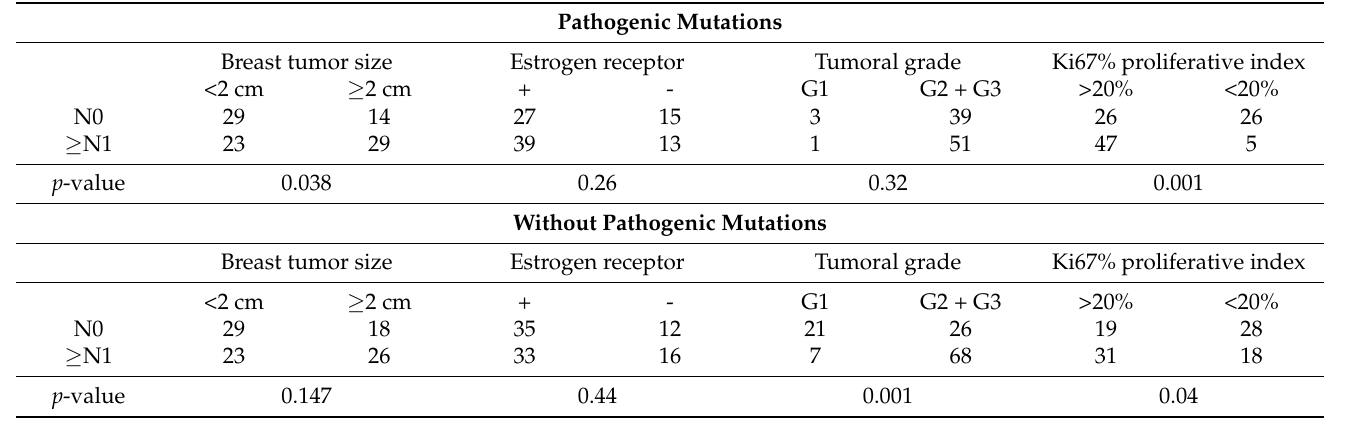
Table 3. Axillary nodal status and immunohistochemistry and histology findings.